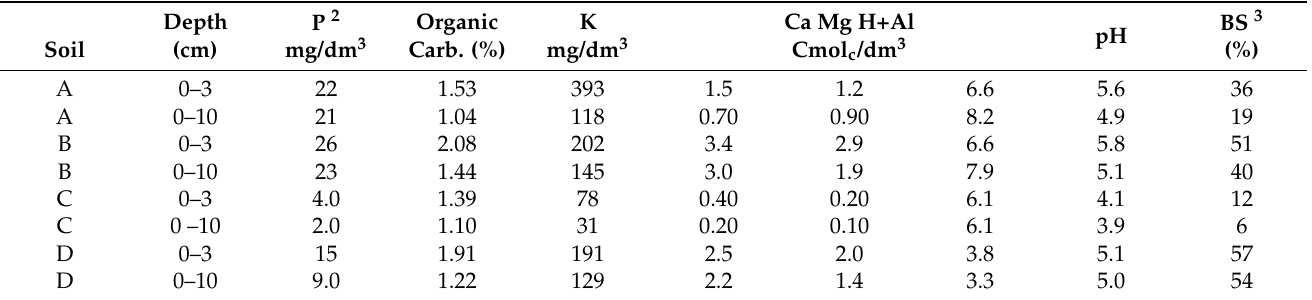
Table 1. Analysis of soils sampled at different depths. The subsamples ( n = 12) were taken with a probe and bulked to a composite sample for each depth. The 0 to 3 cm samples were taken about 4 cm from the place where the 0 to 10 cm samples were taken 1